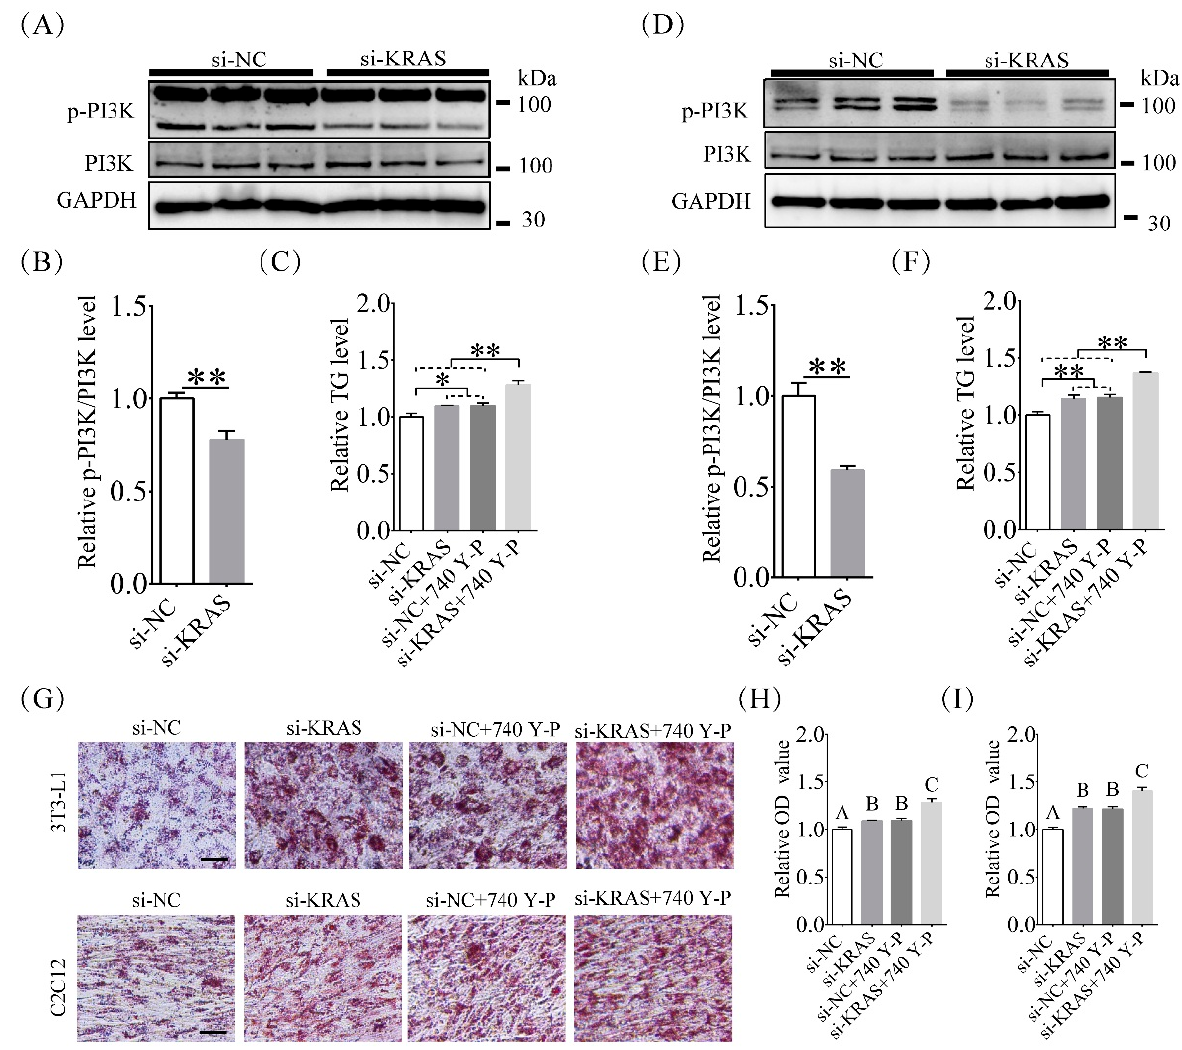
(Figure 5G,H). Among C2C12 cells, the ORO OD values in the si-KRAS, si-NC + 740 Y-P, and si-KRAS + 740 Y-P groups were 1.22 ± 0.02-fold, 1.22 ± 0.02-fold, and 1.40 ± 0.04-fold of those in the NC group, respectively (Figure 5G,I). These results indicated that inhibition of KRAS decreased PI3K phosphorylation levels in 3T3-L1 and C2C12 cells.